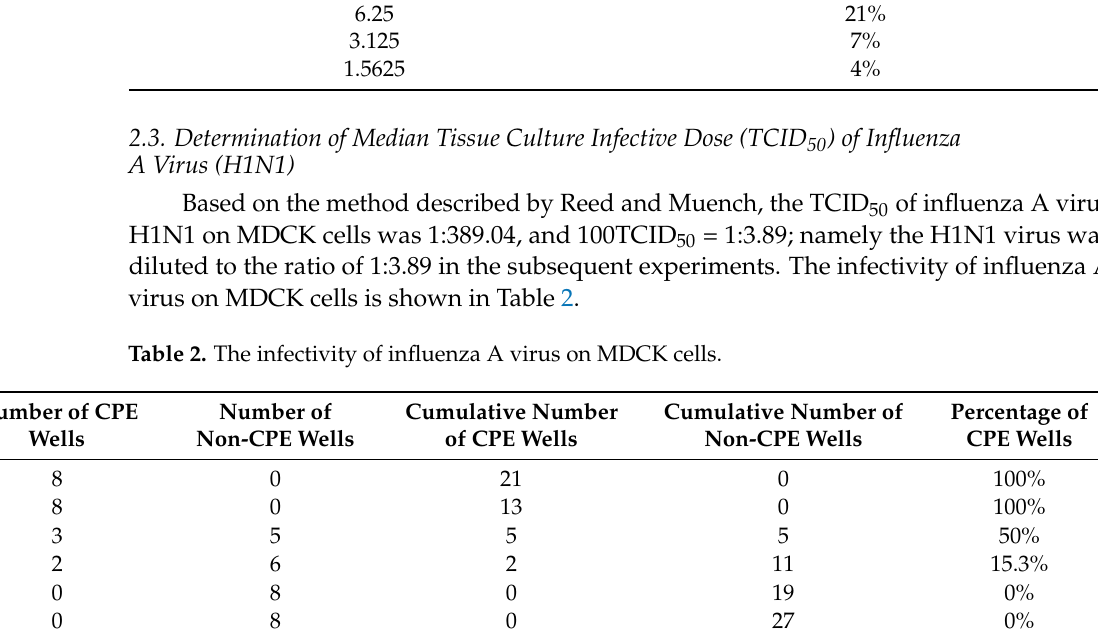
Figure 2. HPLC chromatogram sesquiterpenes with different compounds: 11(13)-dihydrotelekint ( 1 ), telekin ( 2 ), carabrone ( 3 ).